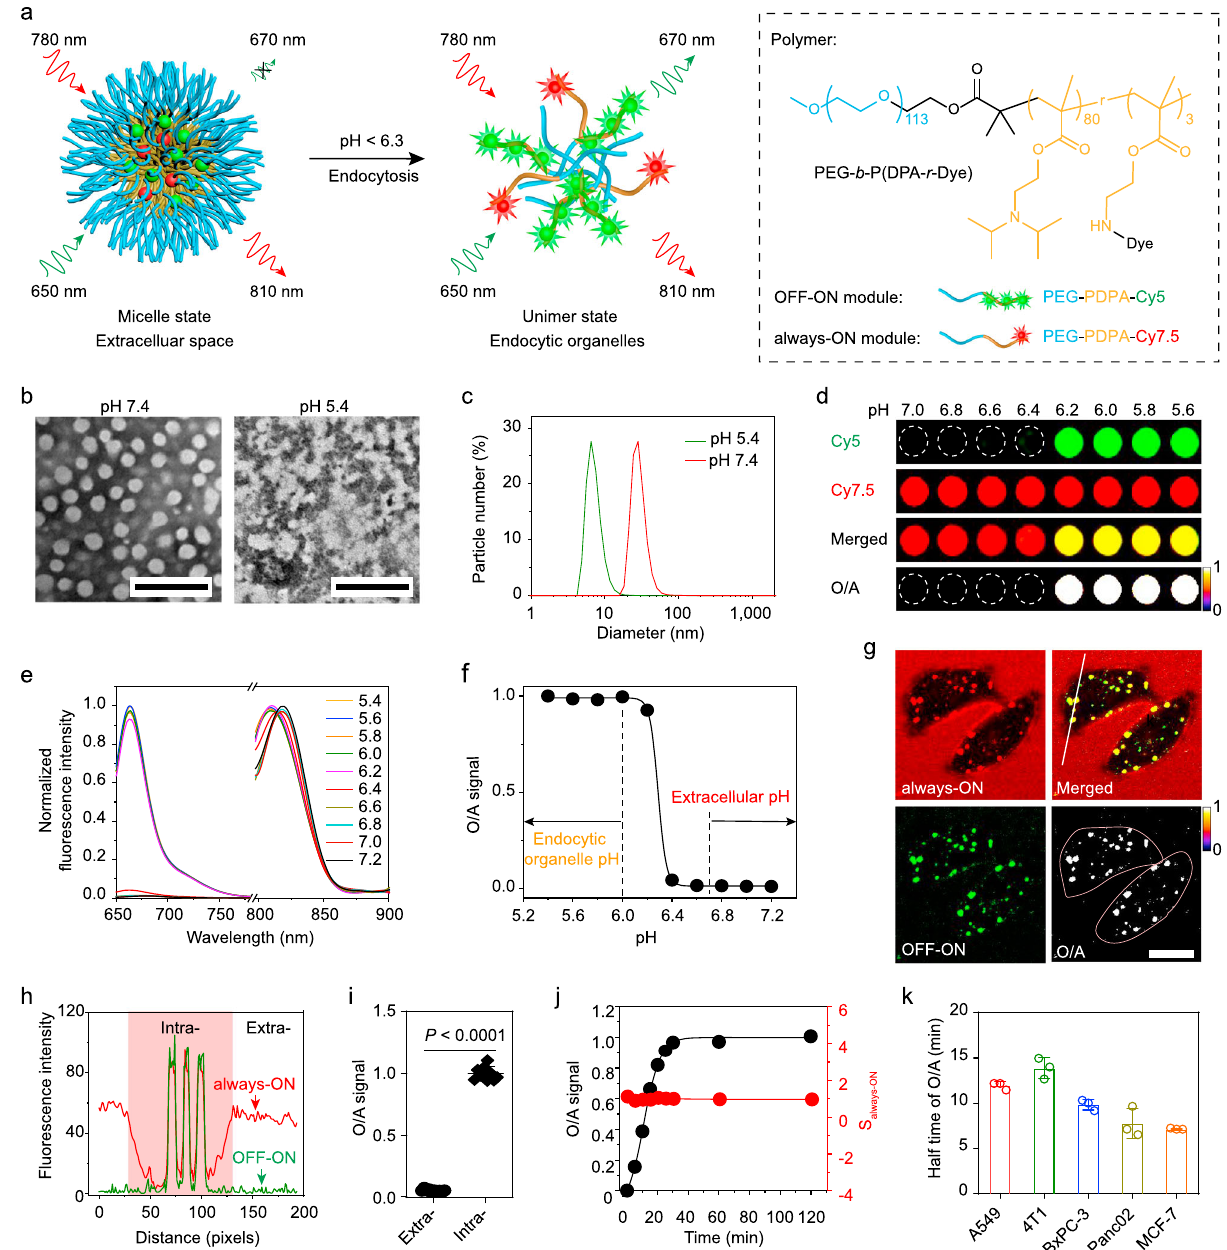
Fig. 2 In vitro characterisation of the BiRN. a Schematic design of the BiRN. b Representative TEM images of micelle at pH 7.4 and 5.4. Concentration of polymer, 1 mg mL − 1 , scale bar, 200nm. c Particle size distribution in pH 7.4 and 5.4 measured by dynamic light scattering. Polymer concentration, 1mgmL − 1 . d Fluorescent images of the BiRN solution (100 μ gmL − 1 ) in different pH buffers. e Normalised fl uorescence spectra of the BiRN in various pH solutions, which were excited at 635 and 780 nm, respectively. f Normalised O/A signal as a function of pH. At pH>6.4, the value closes to 0. At pH< 6.2, the ratio turns to 1 caused by micelle dissociation. g Confocal images of A549 cells incubated with BiRN (100 μ gmL − 1 ) for 0.5 h. O/A channel images only present the internalised nanoprobes. Pink line distinguishes intracellular region from extracellular culture medium. Scale bar, 20 μ m. h The fl uorescence pro fi les of two modules along the white line in g . i Normalised fl uorescence ratio of extra- and intracellular after cultured with BiRN for 30min. n = 10 extra- or intracellular ROIs were selected for quanti fi cation. **** P < 0.0001, two-sided Student t -test. j , k The kinetics of BiRN internalisation by living cells. j After pulsed with BiRN at 4°C and washed thrice, the A549 cells were chased at 37°C for 2h by fl ow cytometry. Mean±s.d. ( n = 3 biologically independent cell samples). The value of s.d. is too small to show. k The heterogeneous half-time of BiRN internalisation in various tumour cells. Mean±s.d. ( n = 3 biologically independent